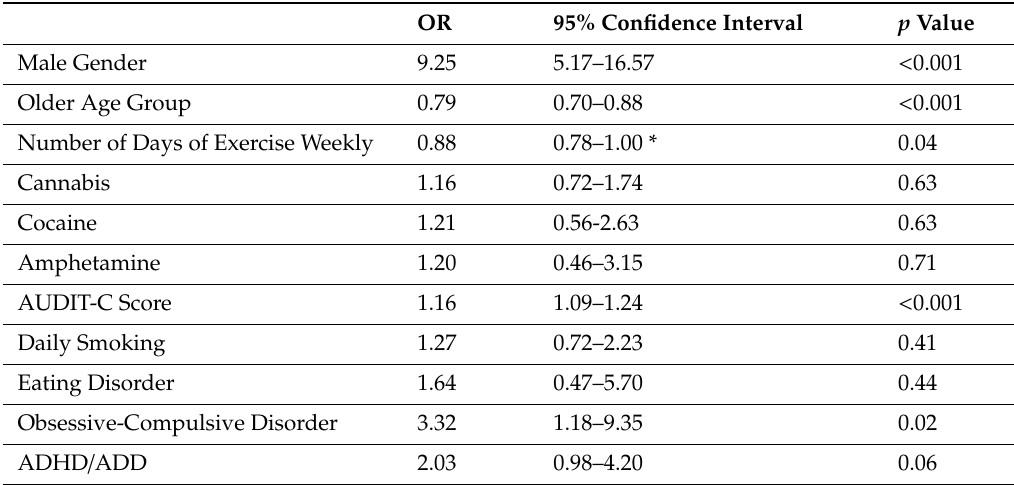
Table 2. Variables associated with problem gambling (defined as the endorsing of at least one Lie / Bet item). Logistic